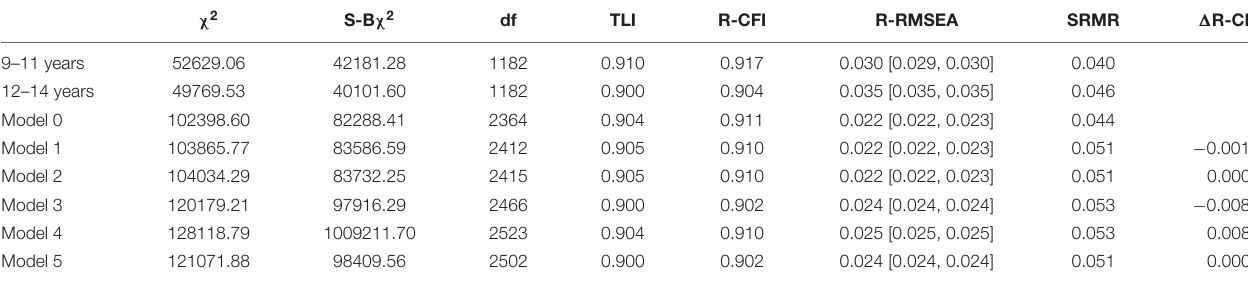
TABLE 5 | Goodness-of-fit indices for invariance of the trimmed model across age. χ 2 S-B χ 2 df TLI R-CFI